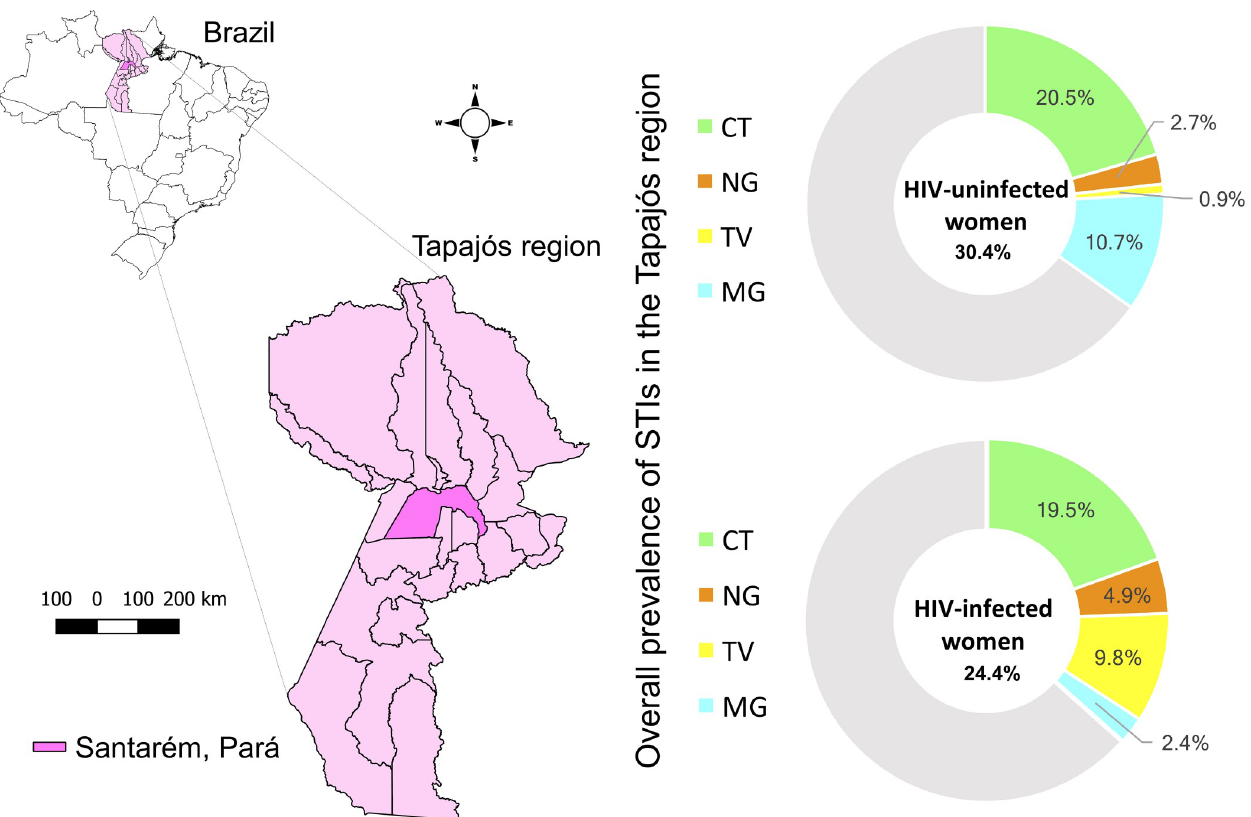
Fig 1. Representative map of the Tapajo´s region in northern Brazil. Highlight for Santare´m and the 22 neighboring municipalities and the overall prevalence of